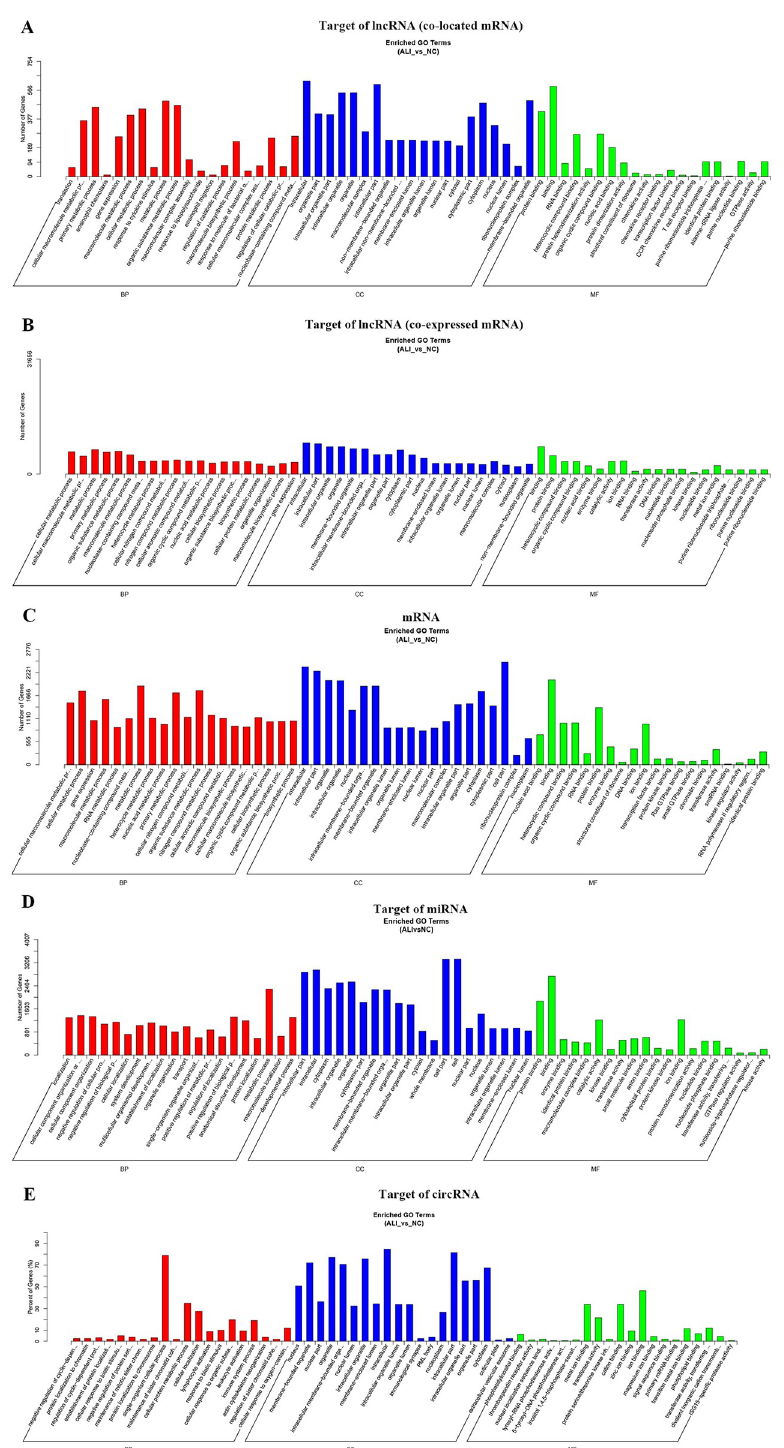
Fig 4. GO annotation. (A)-(D) The bar charts of GO annotation analysis for the target of lncRNAs, DE mRNAs, target of miRNAs, and target of circRNAs.